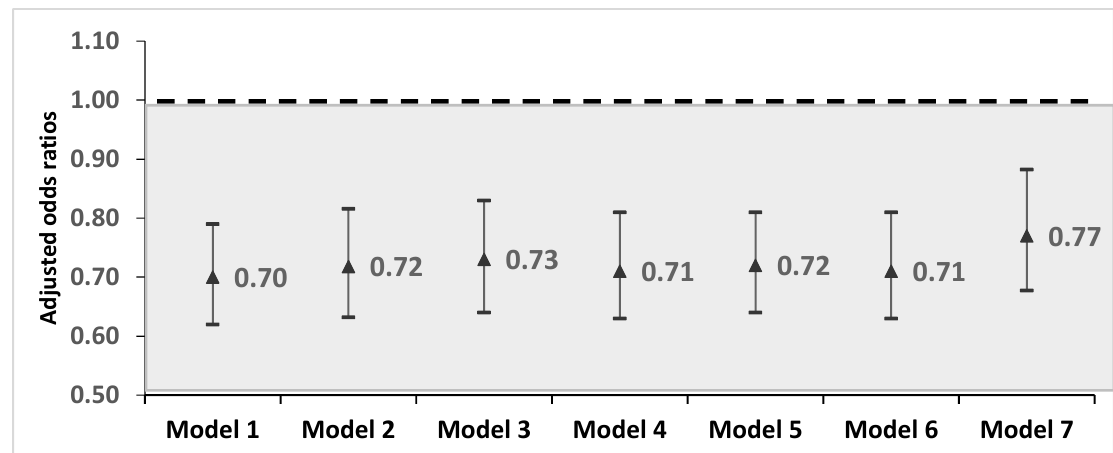
Figure 1. Adjusted odds ratios and 95% confidence intervals for anxiety disorders among immigrants (n = 4733) compared to Canadian-born respondents (n = 22,258). Model 1 (Core)—Demographics: Immigrant status, age, sex; Model 2 (Social and Economic Characteristics)—Model 1 plus: Income, marital status, education; Model 3 (Physical Health)—Model 1 plus: Co-morbidities, hypertension, chronic pain; Model 4 (Health Behaviors)—Model 1 plus: smoking, binge drinking, physical activity, family physician visits; Model 5 (Anthropometric Measures)—Model 1 plus: Disease risk, percent body fat, waist to hip ratio, waist to height ratio; Model 6 (Dietary Intakes)—Model 1 plus: Fiber, pulses/nuts, fat sources, fish sources, omega 3 eggs, fruits and vegetables, pure fruit juice, salty snacks, calcium sources with high vitamin D content, calcium sources with low vitamin D content, pastries, chocolate bars; Model 7 (Complete)—Adjusted for all aforementioned variables Table 2. Adjusted odds ratios of anxiety disorders by immigrant status, socio-demographic, physical health, health behavior, over- and under-nutrition, and dietary measures (Model 7). Variable aOR (95% CI) P -value Demographic, Social, and Economic Characteristics